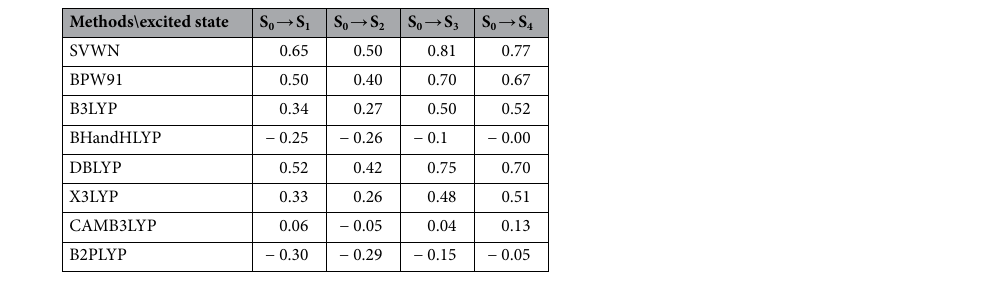
Table 2. Errors for the transition energies of the first four excited states between CCSD and the eight different DFT methods for Zn 2 S